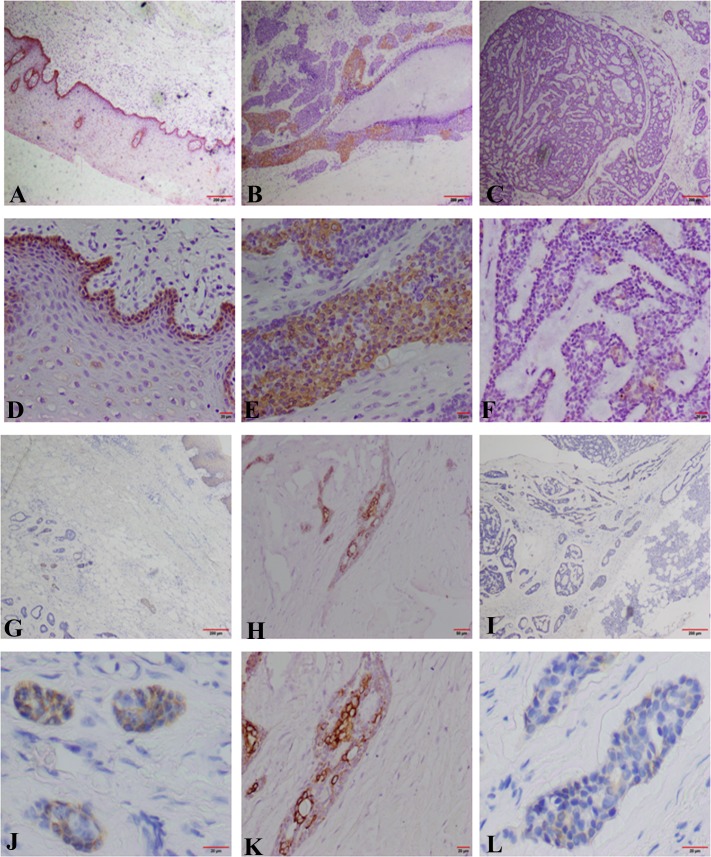
CK14 photomicrographs in the invasive front of SACC with IHC.(A, D) Positive expression of CK14 in oral mucuous tissue (A×100; D×400); (B, E) Positive expression of CK14 in the invasive front of SACC with solid pattern (B×100; E×400); (C, F) Positive expression of CK14 in the invasive front of SACC with cribriform pattern (C×100; F×400). The CK14 positive expression in invasive front in cribriform pattern was lower than that in solid pattern of SACC; (G, J) Positive expression of CK14 in the invasive front of SACC invasion to oral mucuous tissue (G×100; J×400); (H, K) Positive expression of CK14 in the invasive front of SACC invasion to blood vessel(H×200; K×400); (I, L) Positive expression of CK14 in the invasive front of SACC invasion to gland (I×100; L×400).